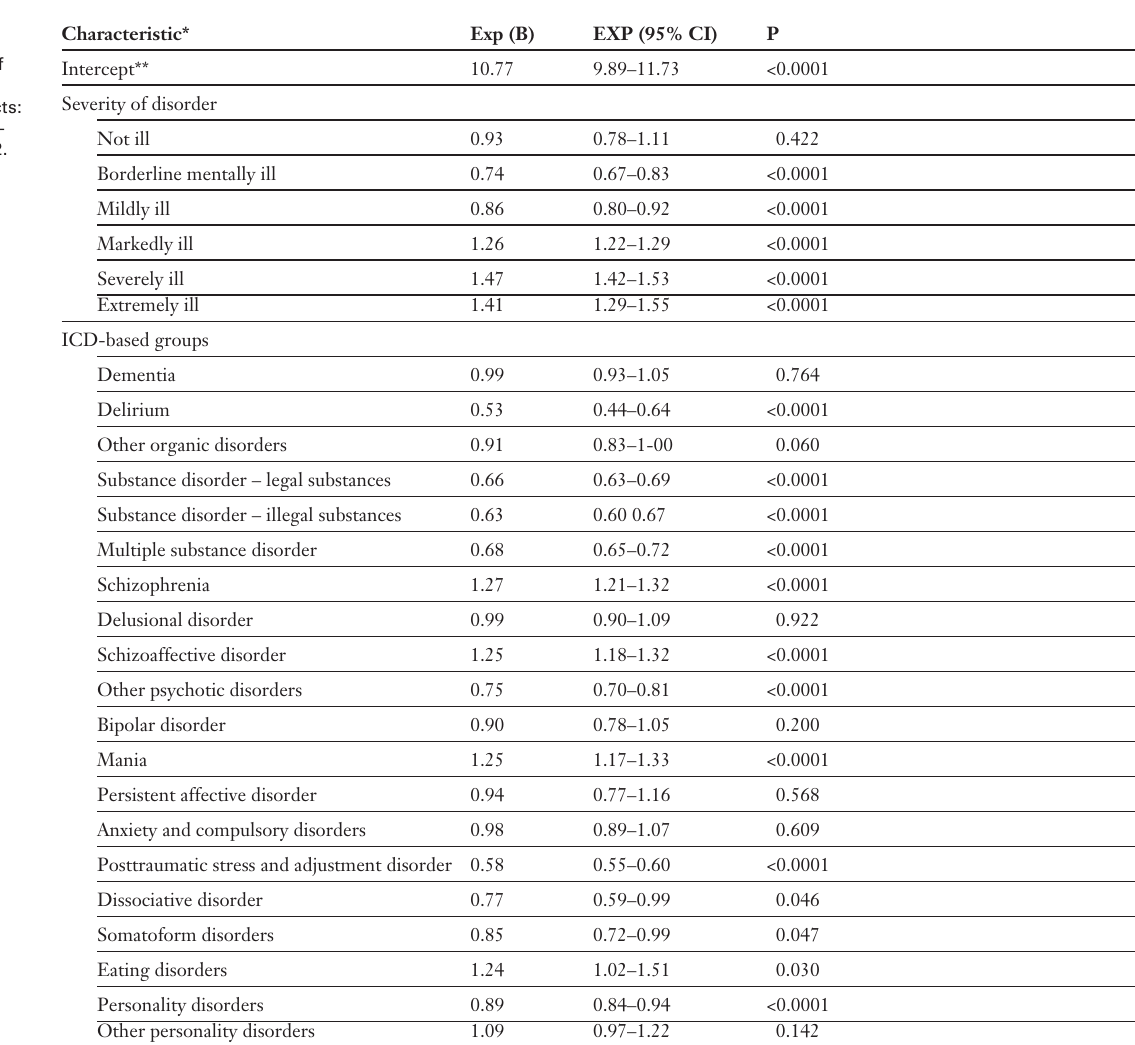
Table 4 Geometric mean of length of stay and multiplicative effects: two sample charac- teristics of model